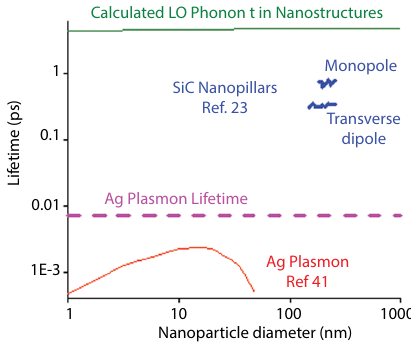
Figure 11 Calculated lifetimes for LO phonons within 4H-SiC nano- structures as a function of diameter (green trace) in comparison to values extracted from the resonance linewidths of SiC nanopillars reported by Caldwell et al. [23] (blue and light blue trace for modes as noted in figure). For comparison, the lifetimes of silver spherical particles are reported by Kreibig and Vollmer [42] (red trace) and extracted from the inverse of the damping constant for Ag are also